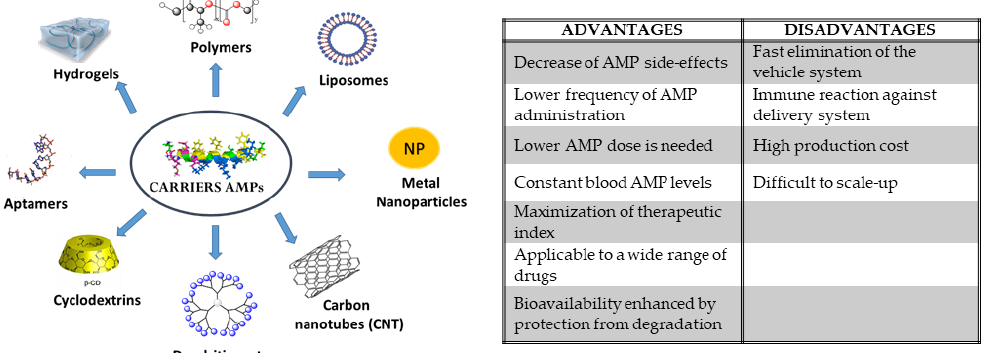
Figure 2. Some examples of AMP carriers and some advantages and disadvantages of their use. Table 1. Advantages and disadvantages of different nanostructures as carriers.